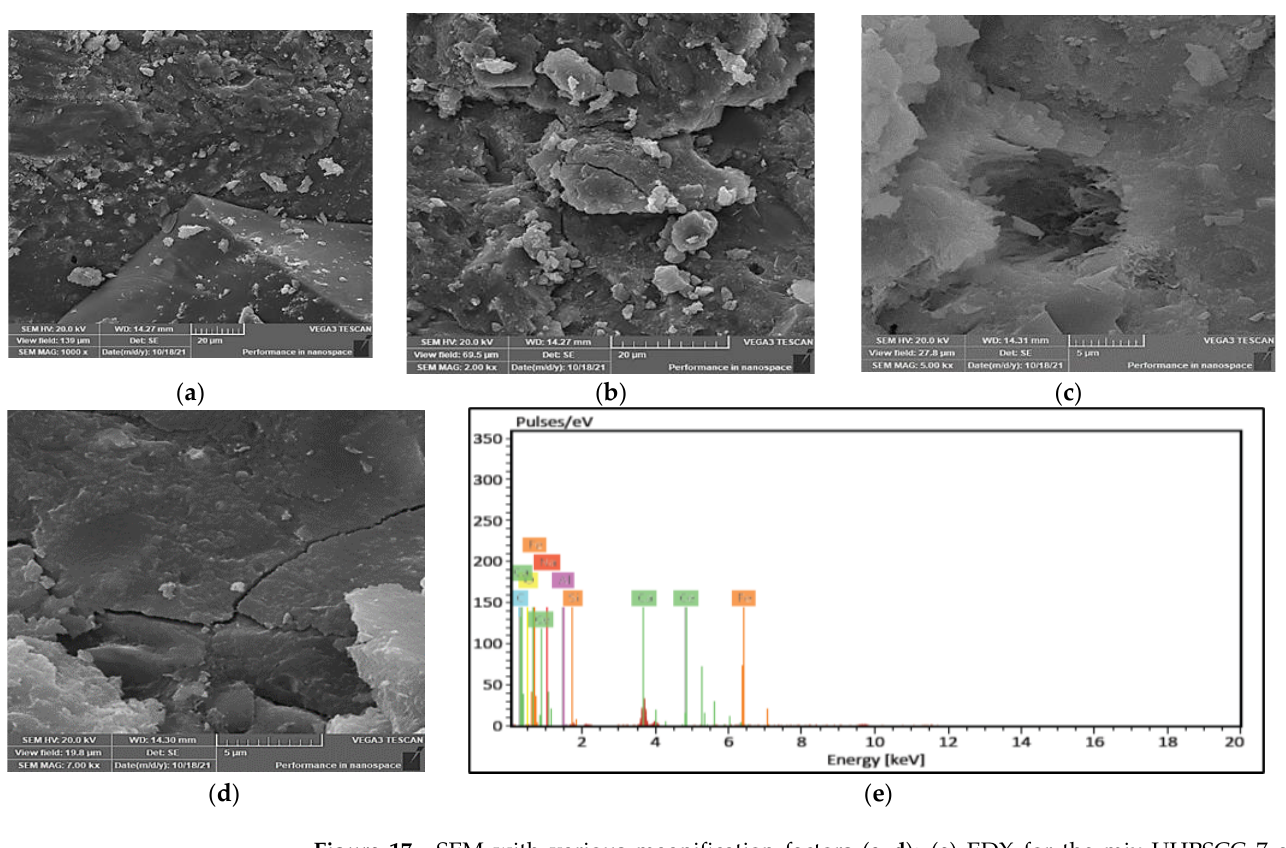
Figure 17. SEM with various magnification factors ( a – d ); ( e ) EDX for the mix UHPSCC 7 at (200 °C) temperature.